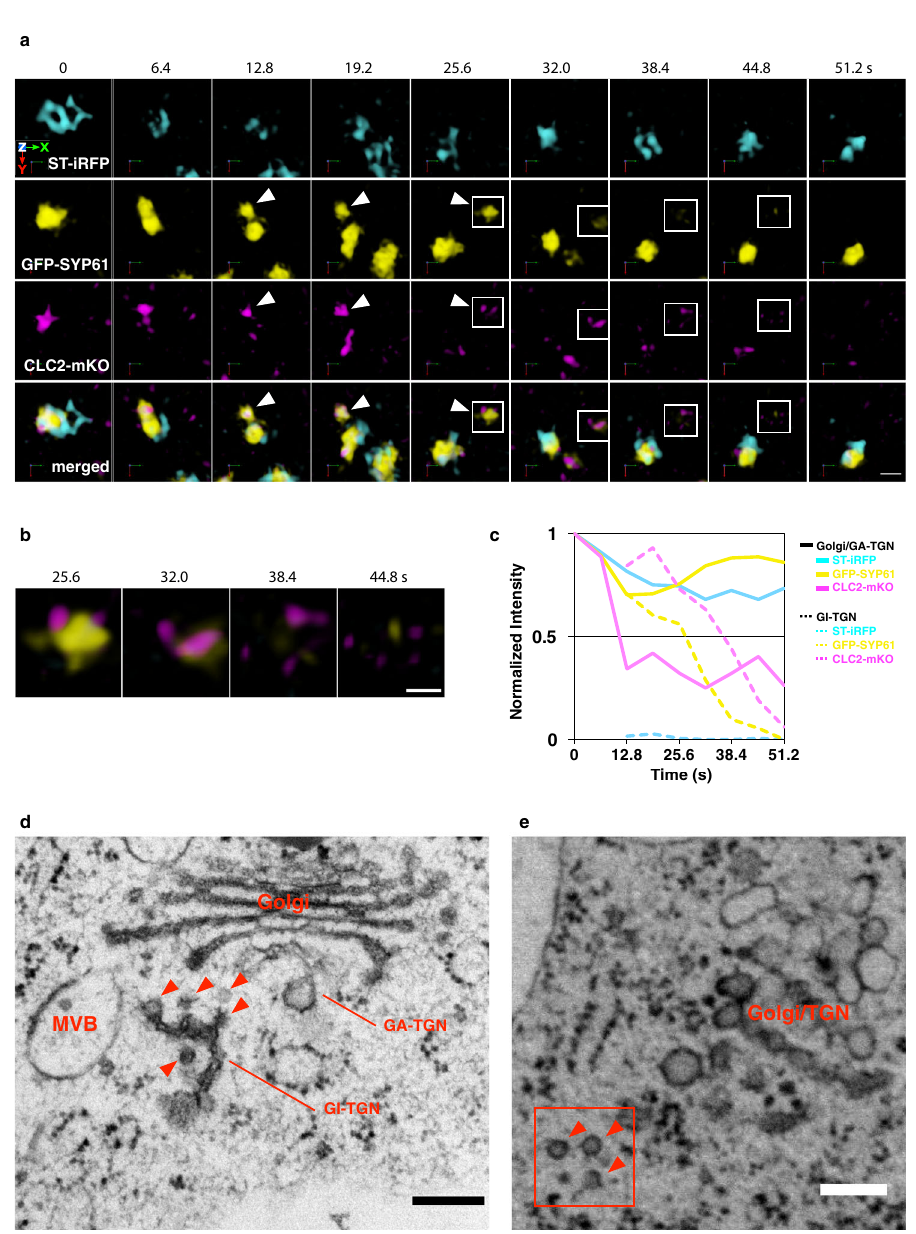
Fig. 6 Temporal relation between and ultrastructure of the Golgi apparatus, TGN, and secretory traf fi cking zone component clathrin. a 4D images of ST-iRFP, GFP-SYP61, and CLC2-mKO in the epidermal cell of the root elongation zone under SCLIM. White arrowheads indicate dissociation of CLC2 and SYP61 subpopulation from the major population of the TGN (GA-TGN) labeled with GFP-SYP61. b Magni fi ed images of boxed area in a . Images are lined up every 6.4 s from left to right. c Time course changes in relative fl uorescence intensities of ST-iRFP, GFP-SYP61, and CLC2-mKO in the Golgi/GA-TGN or GI-TGN area in a . d , e Transmission electron microscopic images of Arabidopsis root epidermal cells. Arrowheads indicate clathrin-coated vesicles/buds. Boxed area shows the CCV cluster. The experiments were repeated independently at least three times with similar results, and micrographs from representative experiments are presented. Scale bars = 1 μ m ( a ); 500 nm ( b ); 200 nm ( d , e